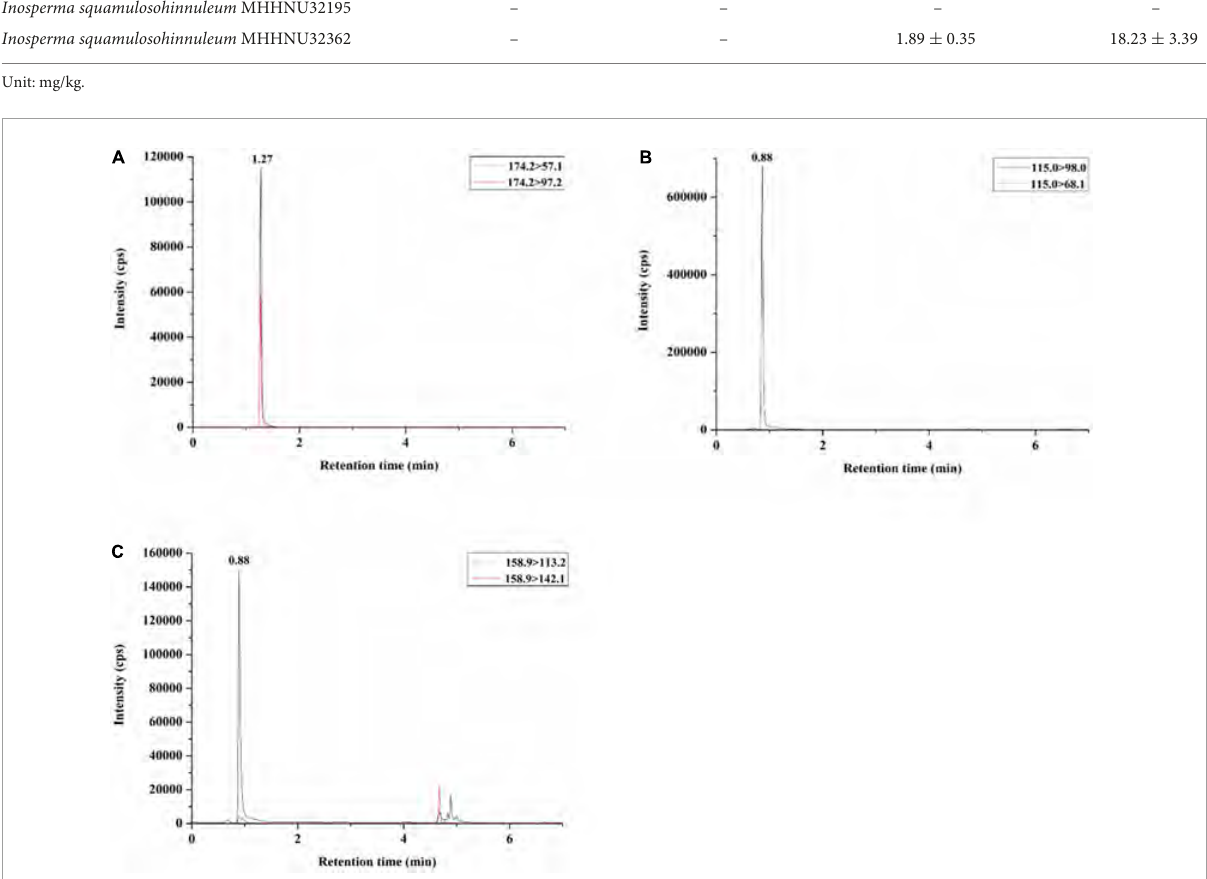
FIGURE12 Total ion current (TIC) chromatogram of neurotoxins in positive mushroom samples: (A) muscarine (MHHNU 31689); (B) muscimol (MHHNU 32359); and (C) ibotenic acid (MHHNU